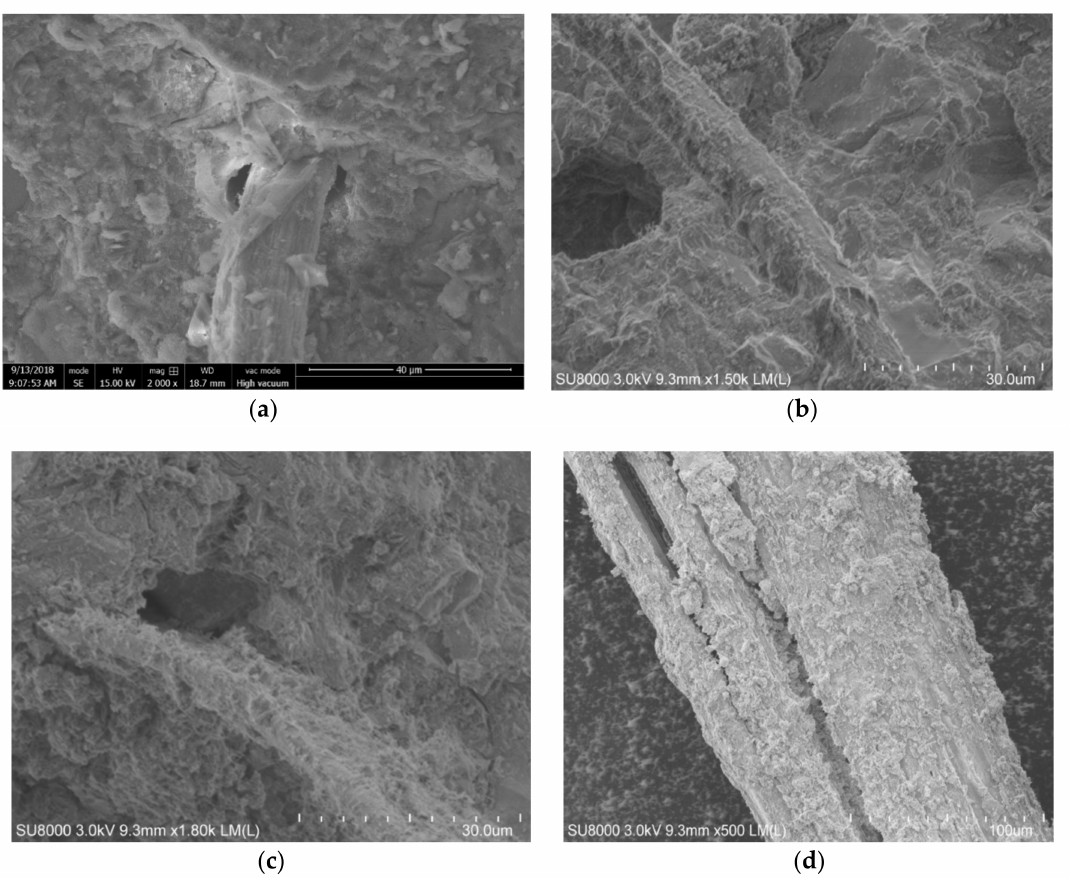
Figure 10. SEM images of the fractured surfaces of ( a ) untreated fiber, ( b ) fiber treated with aluminate ester, ( c ) fiber treated with glycerol, and ( d ) a single fiber treated with silane.